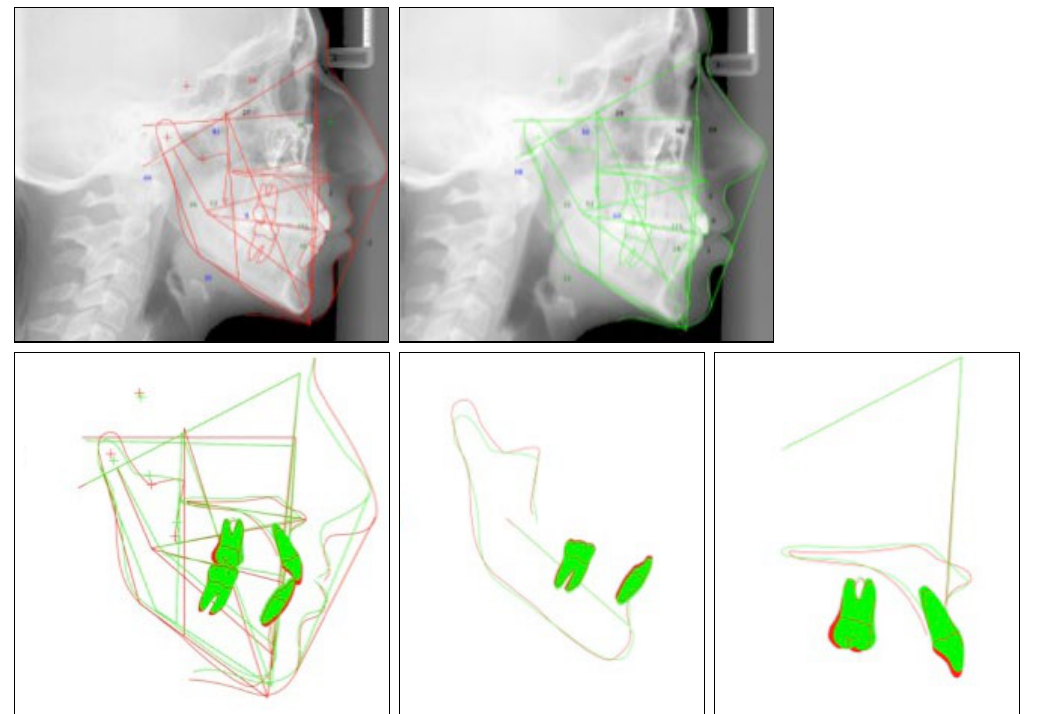
Figure 10. Cephalometric superimpositions. Red line, post-treatment; green line,